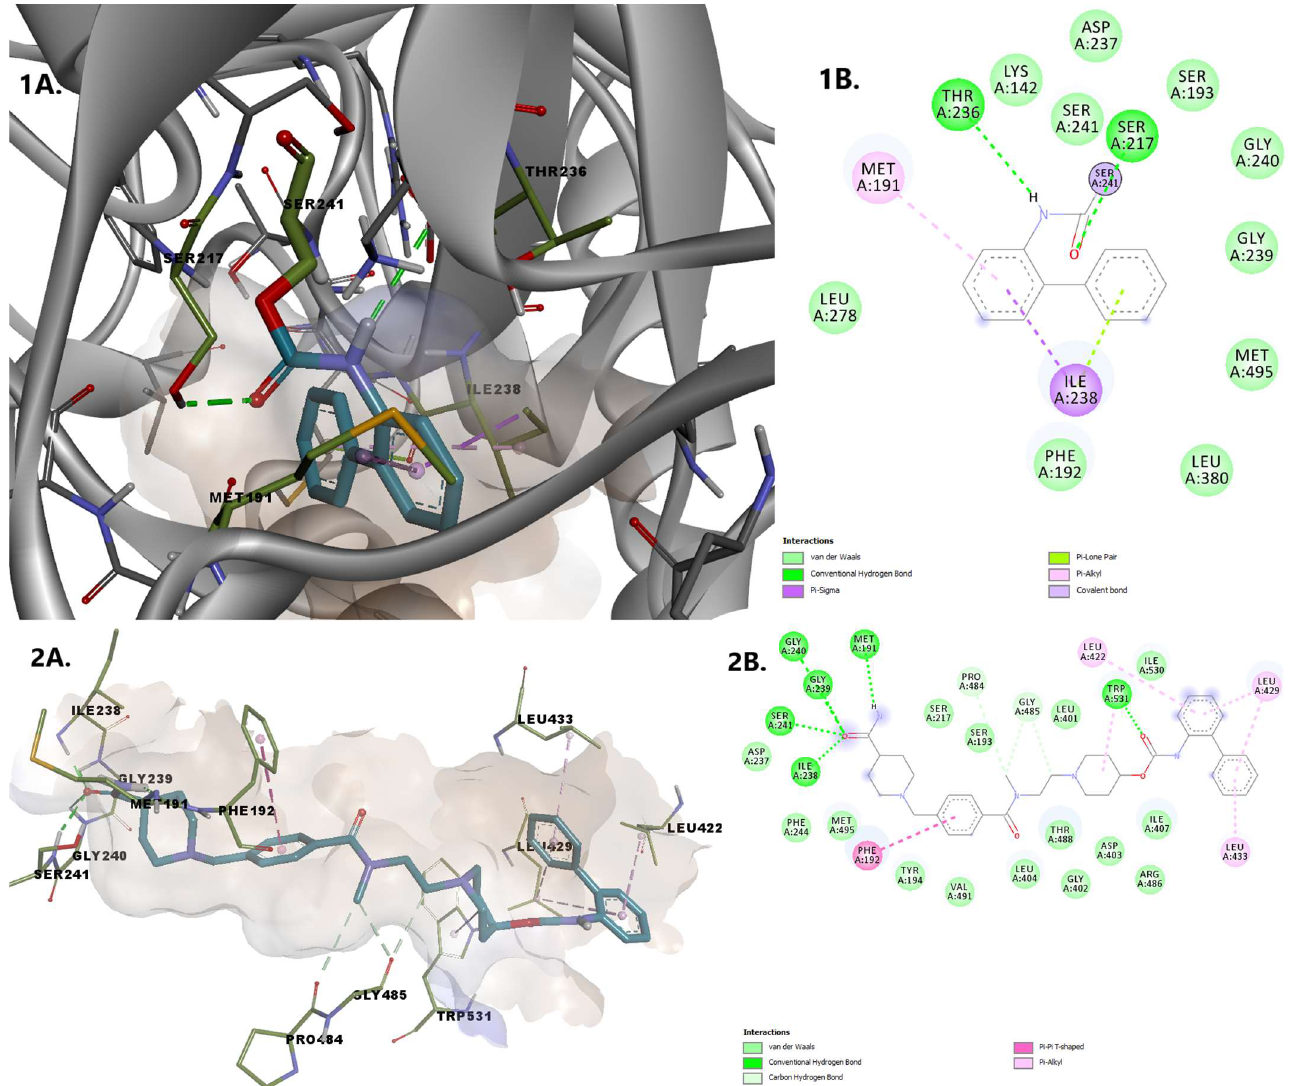
Figure 8. Overlay of revefenacin in the two bound states 1. Covalently bound revefenacin ( A ) 3D binding conformation to FAAH; ( B ) 2D diagram of protein-ligand interactions between FAAH and revefenacin. 2. Non-covalently bound revefenacin ( A ) 3D binding conformation to FAAH; ( B ) 2D diagram of protein-ligand interactions between FAAH and revefenacin.